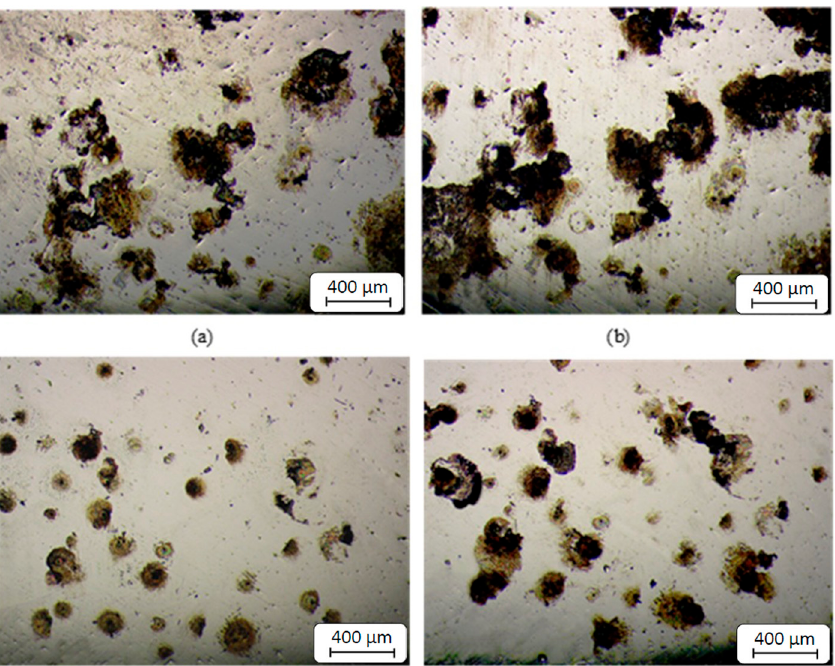
Figure 8. Evolution of corrosion in circular crowns of specimens (50×), ( a ) HM (30 min), ( b ) HM (60 min), ( c ) HM EPT (30 min), ( d ) HM EPT (60 min). Table 7. Evolution of oxidized areas corresponding to circular crowns of specimens.